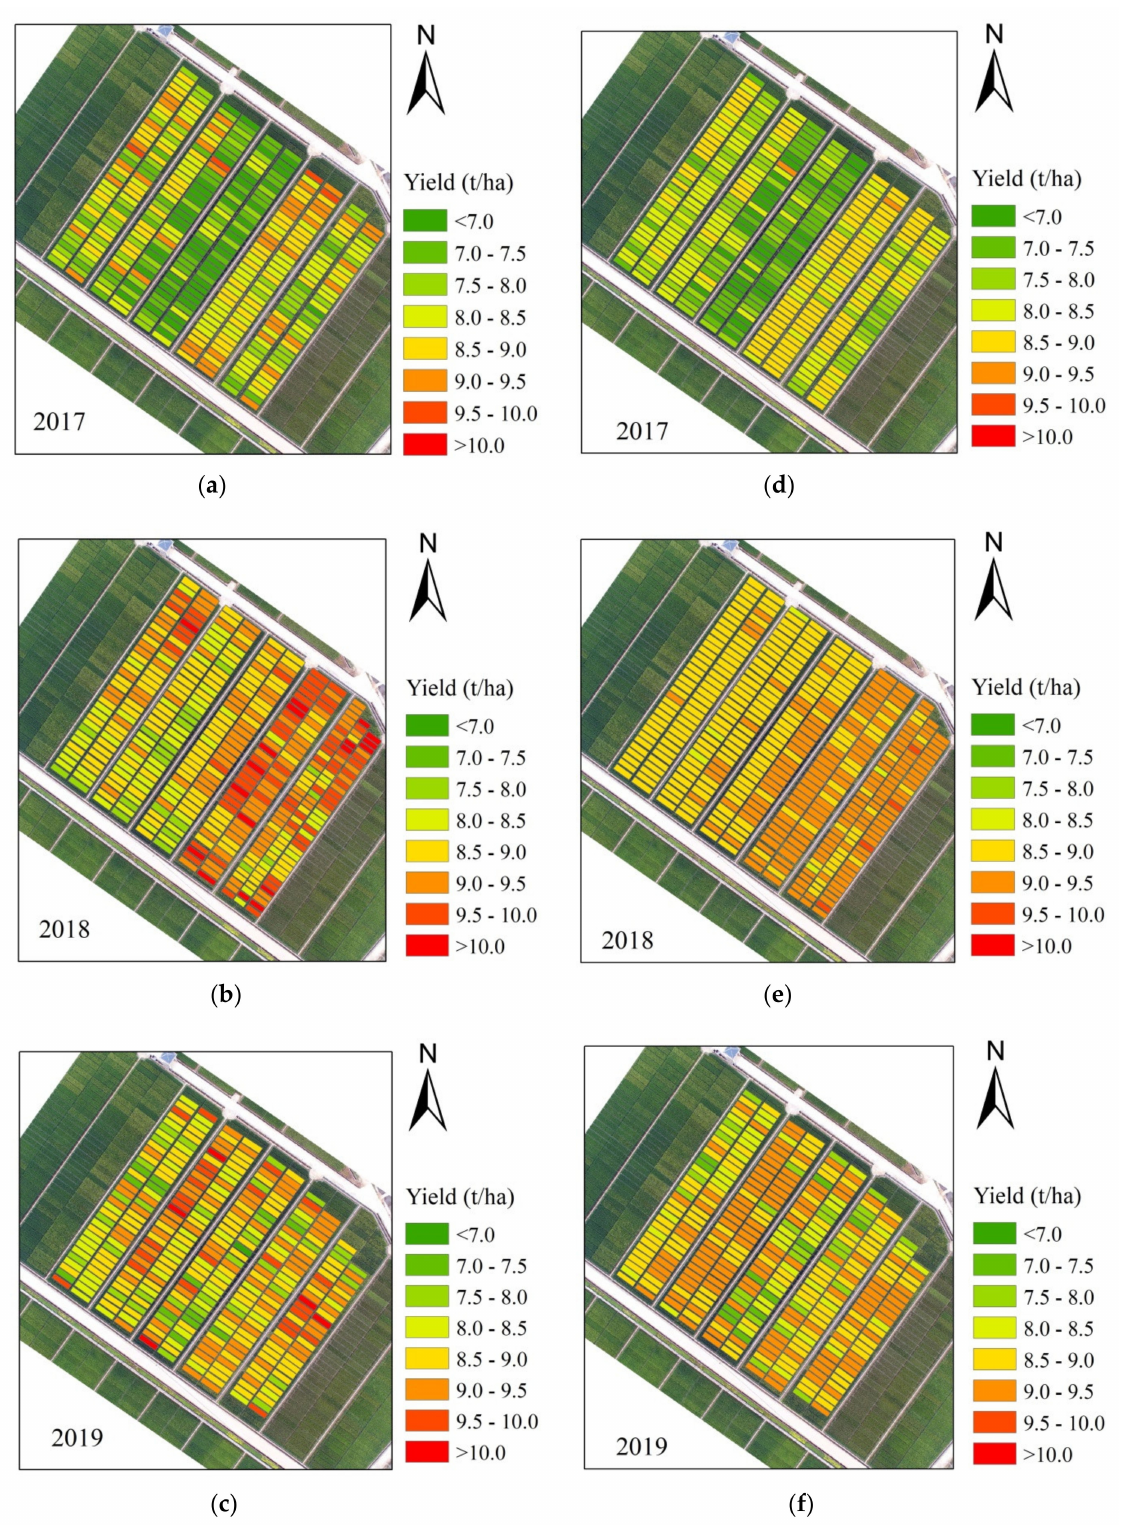
Figure 10. Yield maps in rice breeding from 2017 to 2019: ( a – c ) measured yield and ( d – f ) simulated yield from the optimal RF